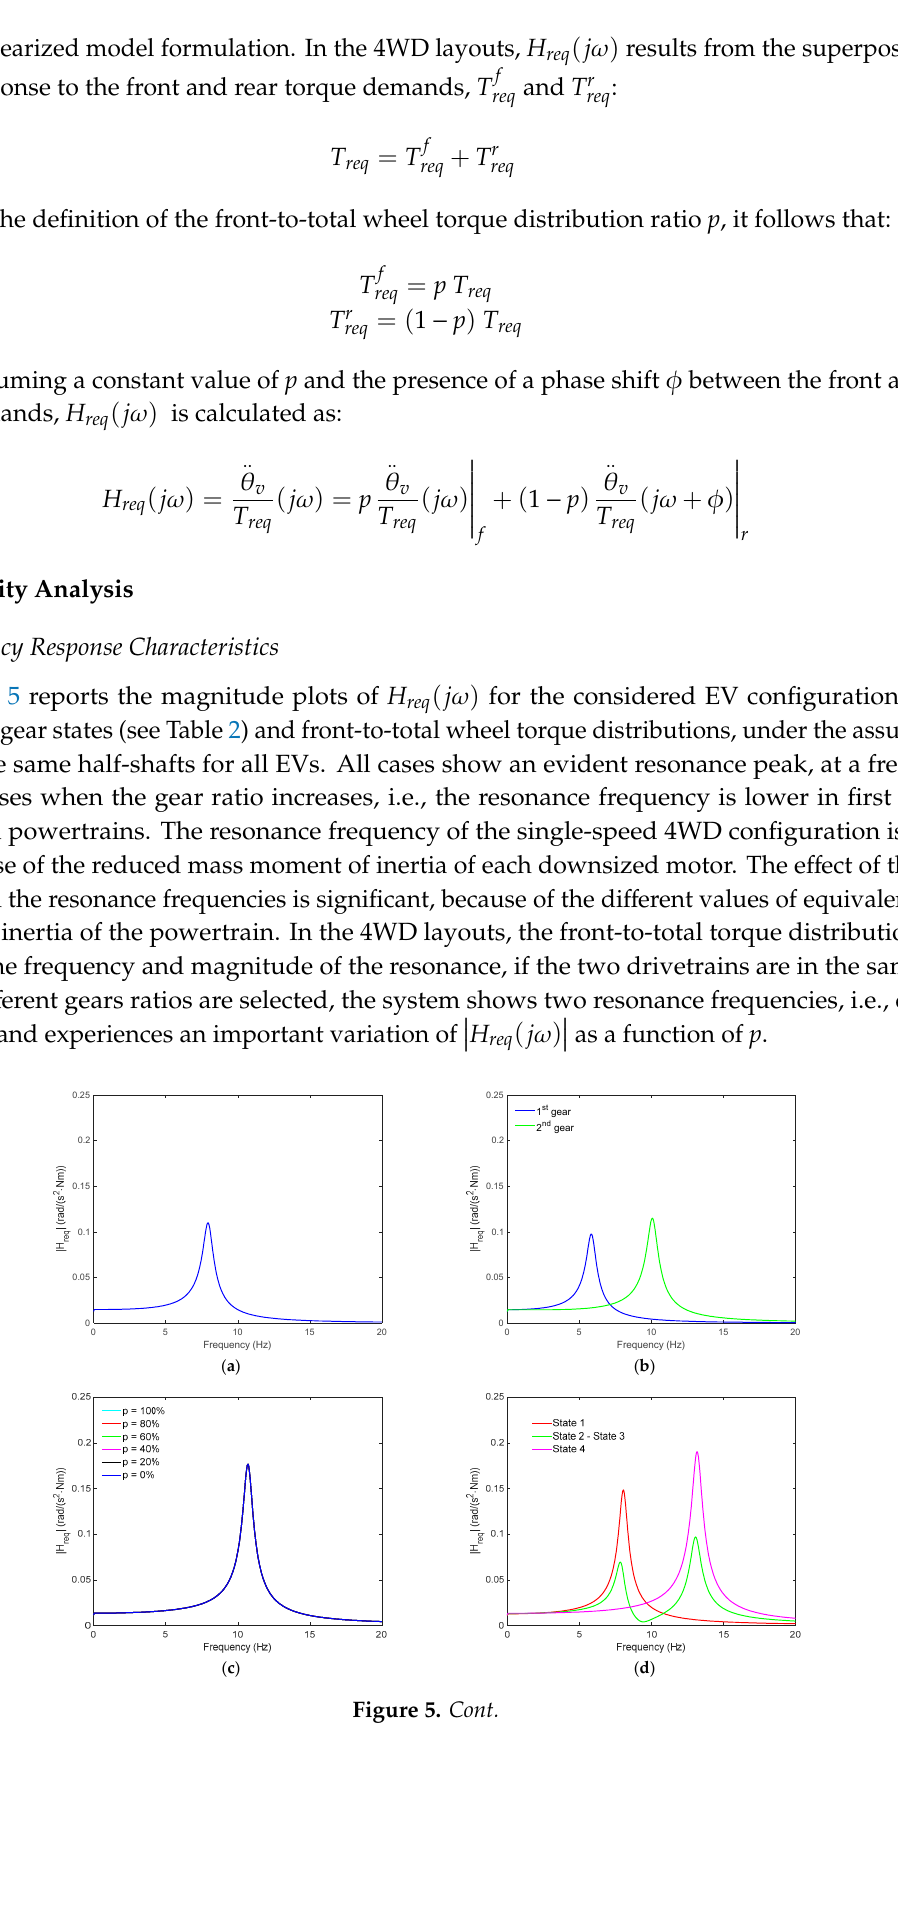
( f ) Figure 5. Examples of magnitude plots of (cid:1834) (cid:3045)(cid:3032)(cid:3044) (cid:4666)(cid:1862)(cid:2033)(cid:4667) for the different EV layouts at 20 km/h: ( a ) L1: Single-speed 2WD; ( b ) L2: 2-speed 2WD; ( c ) L3: Single-speed 4WD; ( d ) L4: 2-speed 4WD (with states indicated according to Table 2); ( e ) L4: 2-speed 4WD (second gear on front axle, first gear on rear axle); ( f ) L4: 2-speed 4WD (second gear on front and rear axles). Figure 6 is a sensitivity analysis on the effect of the phase shift between the front and rear drivetrain torque demands. During real EV operation, input torque phase shifting is inevitable, and can be caused by the variation of the wheel torque distribution decided by the energy management system, the gearshift controller, as well as the interventions of the anti-jerk and traction controllers. The phase shifts affect (cid:3627)(cid:1834) (cid:3045)(cid:3032)(cid:3044) (cid:4666)(cid:1862)(cid:2033)(cid:4667)(cid:3627) especially when different gear ratios are selected on the two axles, in the frequency region between the respective resonances. The important conclusion is that the 2-speed 4WD configuration (L4) is characterized by a significantly increased complexity of its drivability response in constant gear condition, with respect to all the other layouts, and its frequency response is strongly dependent on the selected state, wheel torque distribution, and torque demand phase shift. Hence, such EV architecture needs a more